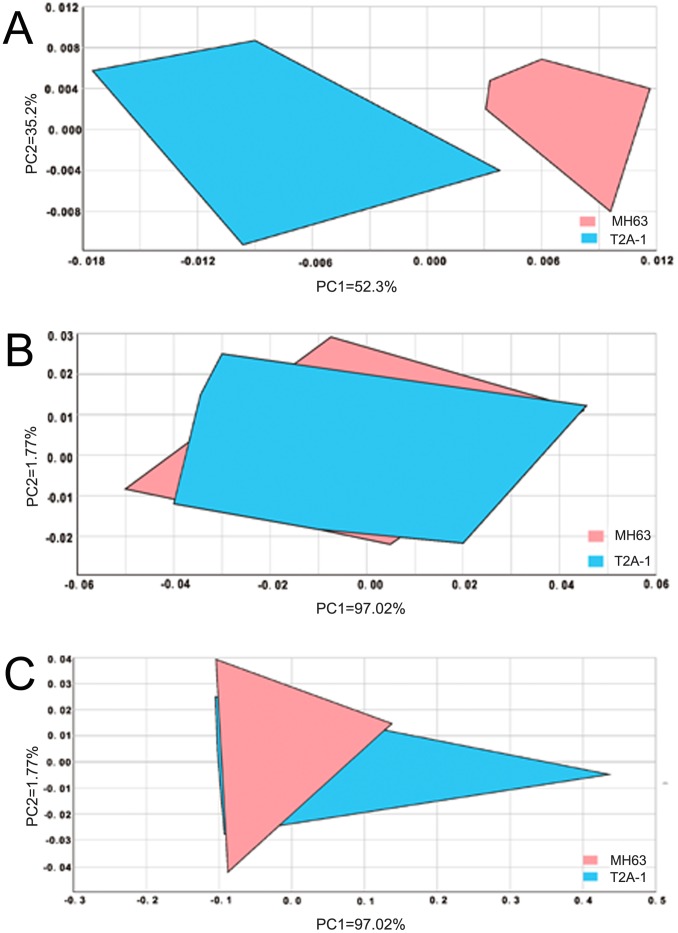
Score plots of PC1 vs. PC2 for the PCAs of leaves from Bt and non-Bt rice cultivars analyzed using an electronic nose: (A) seedling stage (S); (B) tillering stage (T); (C) booting stage (B).